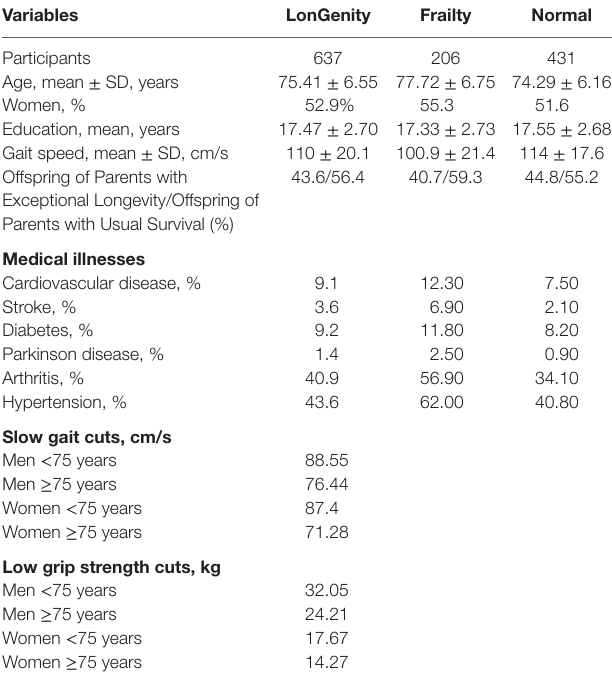
Table 1 | Clinical characteristics of